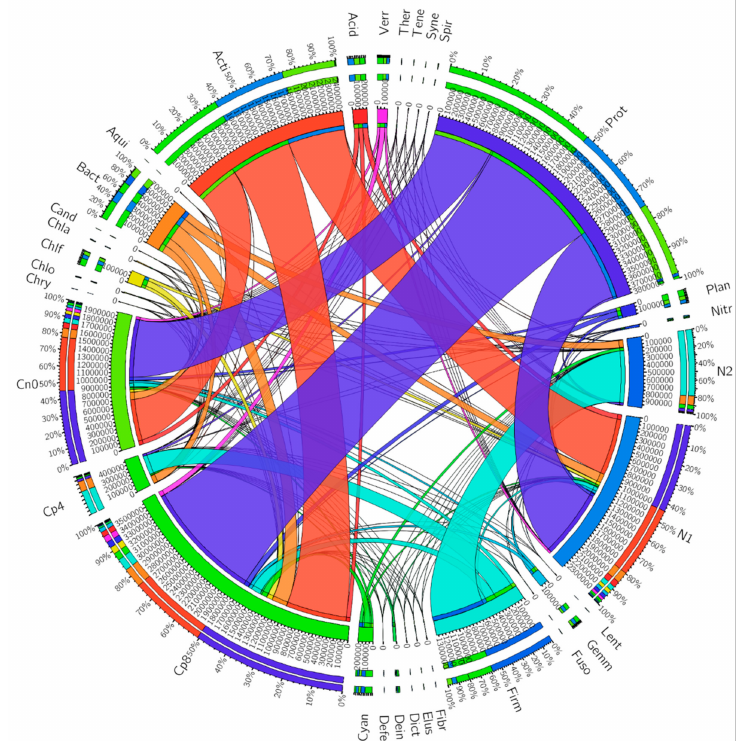
Figure 1. The abundance of bacterial phyla across the treatments from the maize rhizosphere soil sam- ples. Cn0 (control), Cp8 (8 tons/ha compost manure), Cp4 (4 tons/ha compost manure), N2 (120 kg/ha inorganic fertilizer), and N1 (60 kg/ha inorganic fertilizer). The bacteria abbreviations are presented as follows: Acid ( Acidobacteria ), Acti ( Actinobacteria ), Aqui ( Aquificae ), Bact ( Bacteroidetes ), Cand ( Candidatus Poribacteria ), Chla ( Chlamydiae ), Chlo ( Chlorobi ), Chlf ( Chloroflexi ), Chry ( Chrysiogenetes ), Cyan ( Cyanobac- teria ), Defe ( Deferribacteres ), Dein ( Deinococcus - Thermus ), Dict ( Dictyoglomi ), Elus ( Elusimicrobia ), Fibr ( Fibrobacteres ), Firm ( Firmicutes ), Fuso ( Fusobacteria ), Gemm ( Gemmatimonadetes ), Lent ( Lentisphaerae ), Nitr ( Nitrospirae ), Plan ( Planctomycetes ), Prot ( Proteobacteria ), Spir ( Spirochaetes ), Syne ( Synergistetes ), Tene ( Tenericutes ), Ther ( Thermotogae ), Verr ( Verrucomicrobia ). Adapted from Enebe and Babalola